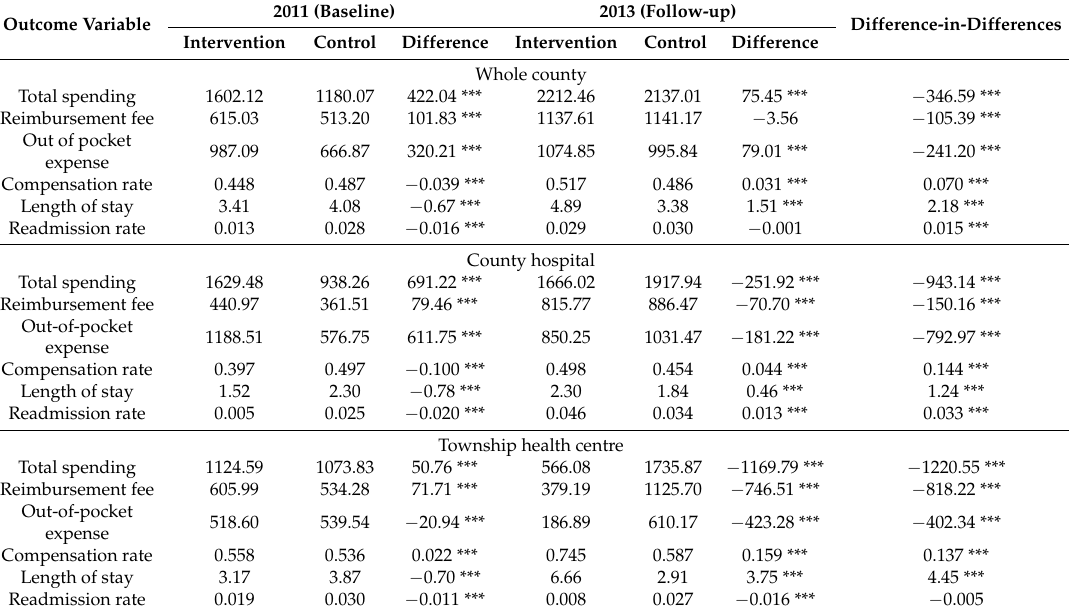
Table 3. Results of difference-in-differences analysis on policy